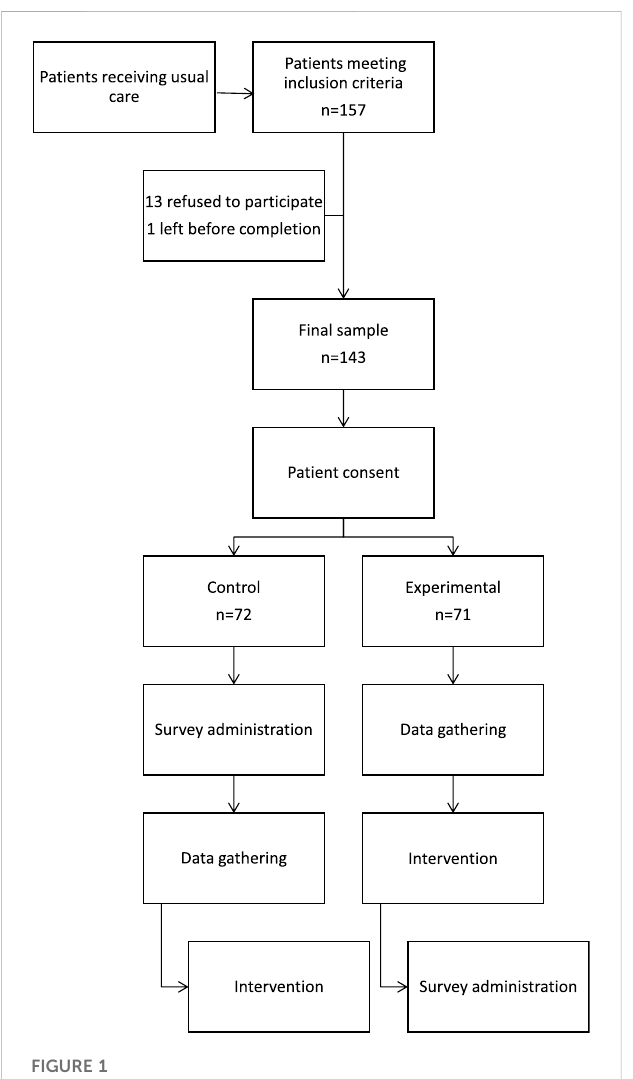
FIGURE 1 Medication optimization intervention fl ow